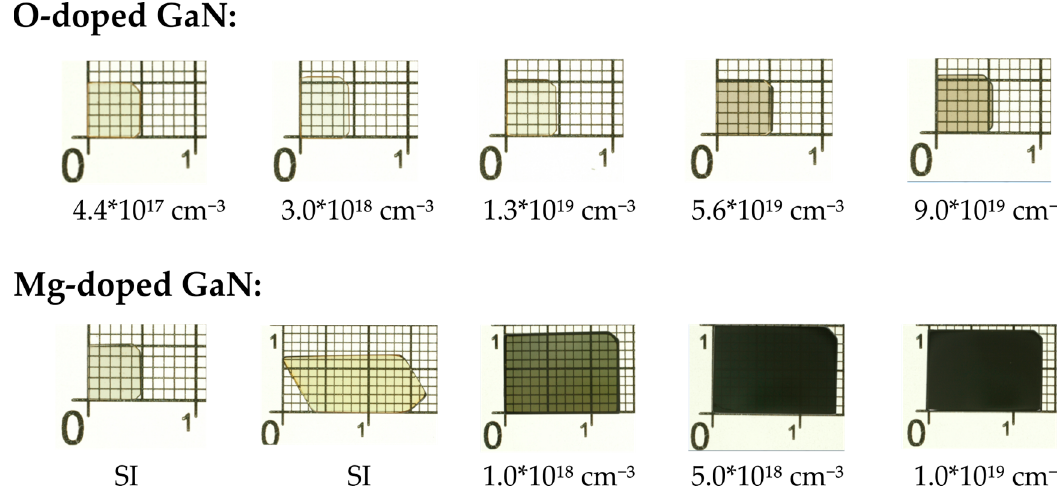
Figure 2. O (top row) and Mg (bottom row) doped GaN crystals of various carrier concentrations.